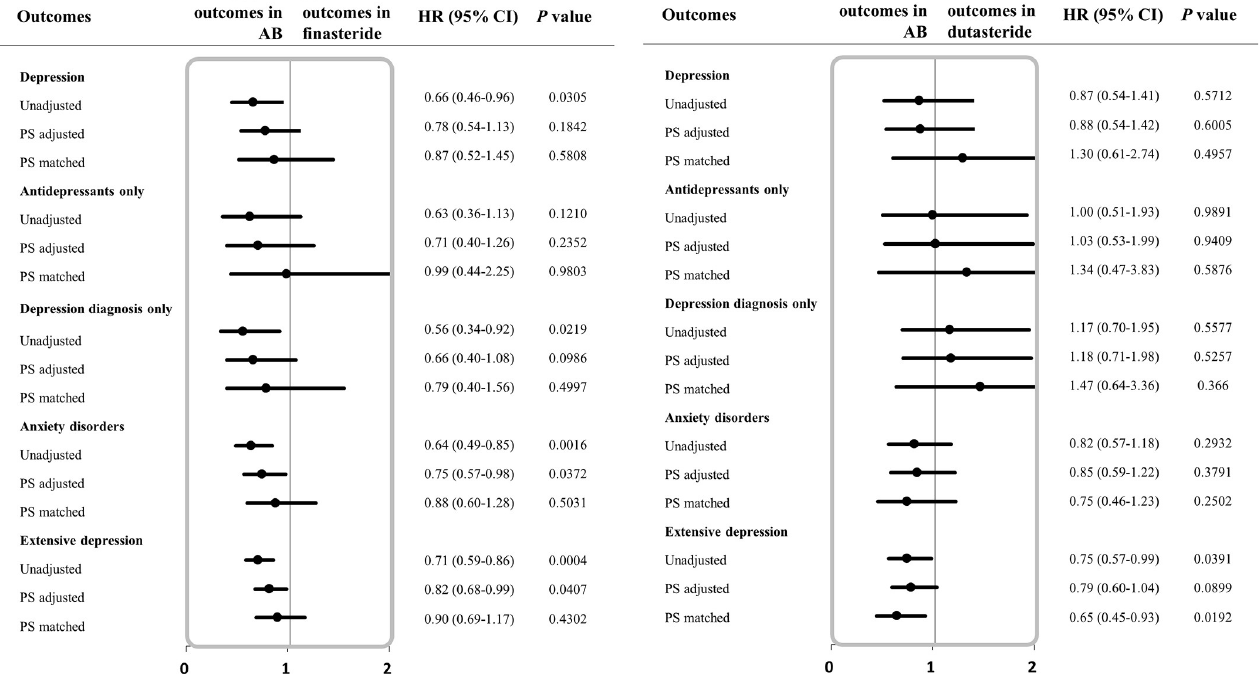
Fig 3. a. Forest plot for hazard ratio related to depressive symptoms among BPH patients exposed to finasteride versus AB. b. Forest plot for hazard ratio related to depressive symptoms among BPH patients exposed to dutasteride versus AB. The study outcomes: depression (classified into 3 categories based on the combination of diagnosis and antidepressants), anxiety disorder, and extensive depression. Abbreviations: BPH, Benign prostatic hyperplasia; AB, alpha blocker; HR, hazard ratio; CI, confidence intervals; PS adjusted, adjusted by propensity score quintiles; PS matched, matched 1:1 by propensity score.